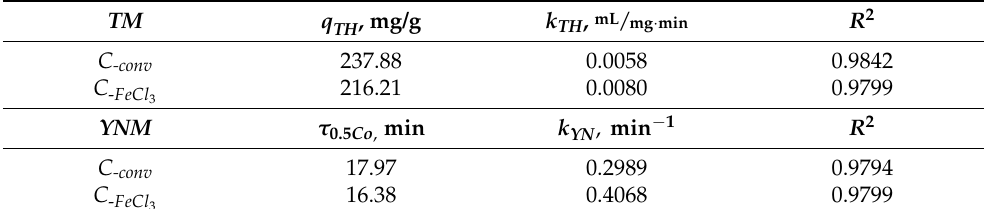
Table 2. Variables of the TM ( q TH , K TH , R 2 ) and YNM ( τ 0.5 Co , K YN , R 2 ) for C -conv and C - FeCl Bordeaux